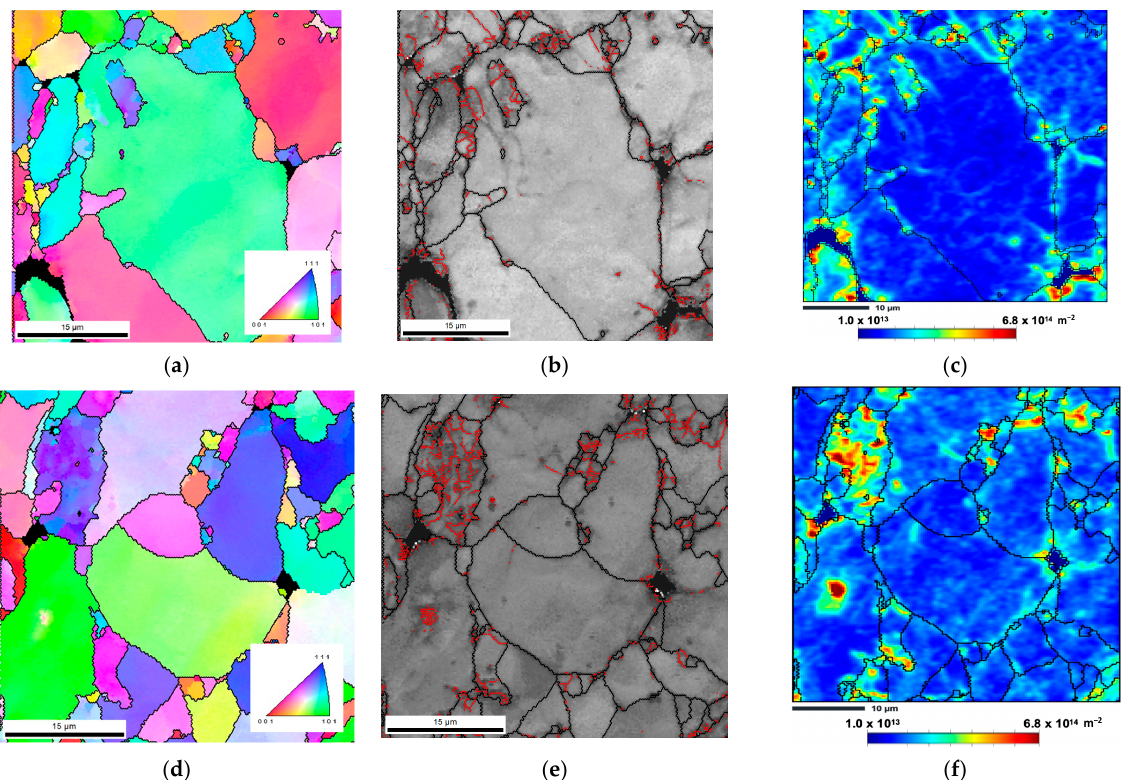
Figure 9. ( a , d ) Inverse pole fi gure (IPF) maps, ( b , e ) grain boundaries maps with LAGB delineated in red, and ( c , f ) estimated GNDs maps of Al and Al/CNT samples, cold rolled to 0.11. Furthermore, these authors also mention that the presence of CNTs can in fl uence the Bauschinger e ff ect, occurring during the deformation of the nanocomposite after sinter- ing. However, it is worth noting that the deformation processes applied in these works di ff er from the cold rolling used in the present work. These studies cannot be used as guidelines, although they are very helpful in understanding the impact of CNTs on this phenomenon. Increasing the strain above 0.36 does not signi fi cantly change the LAGB fraction and slightly increases the HAGB for the nanocomposites. This increase can be explained due to the transformation of some LAGB into HAGB. A more signi fi cant